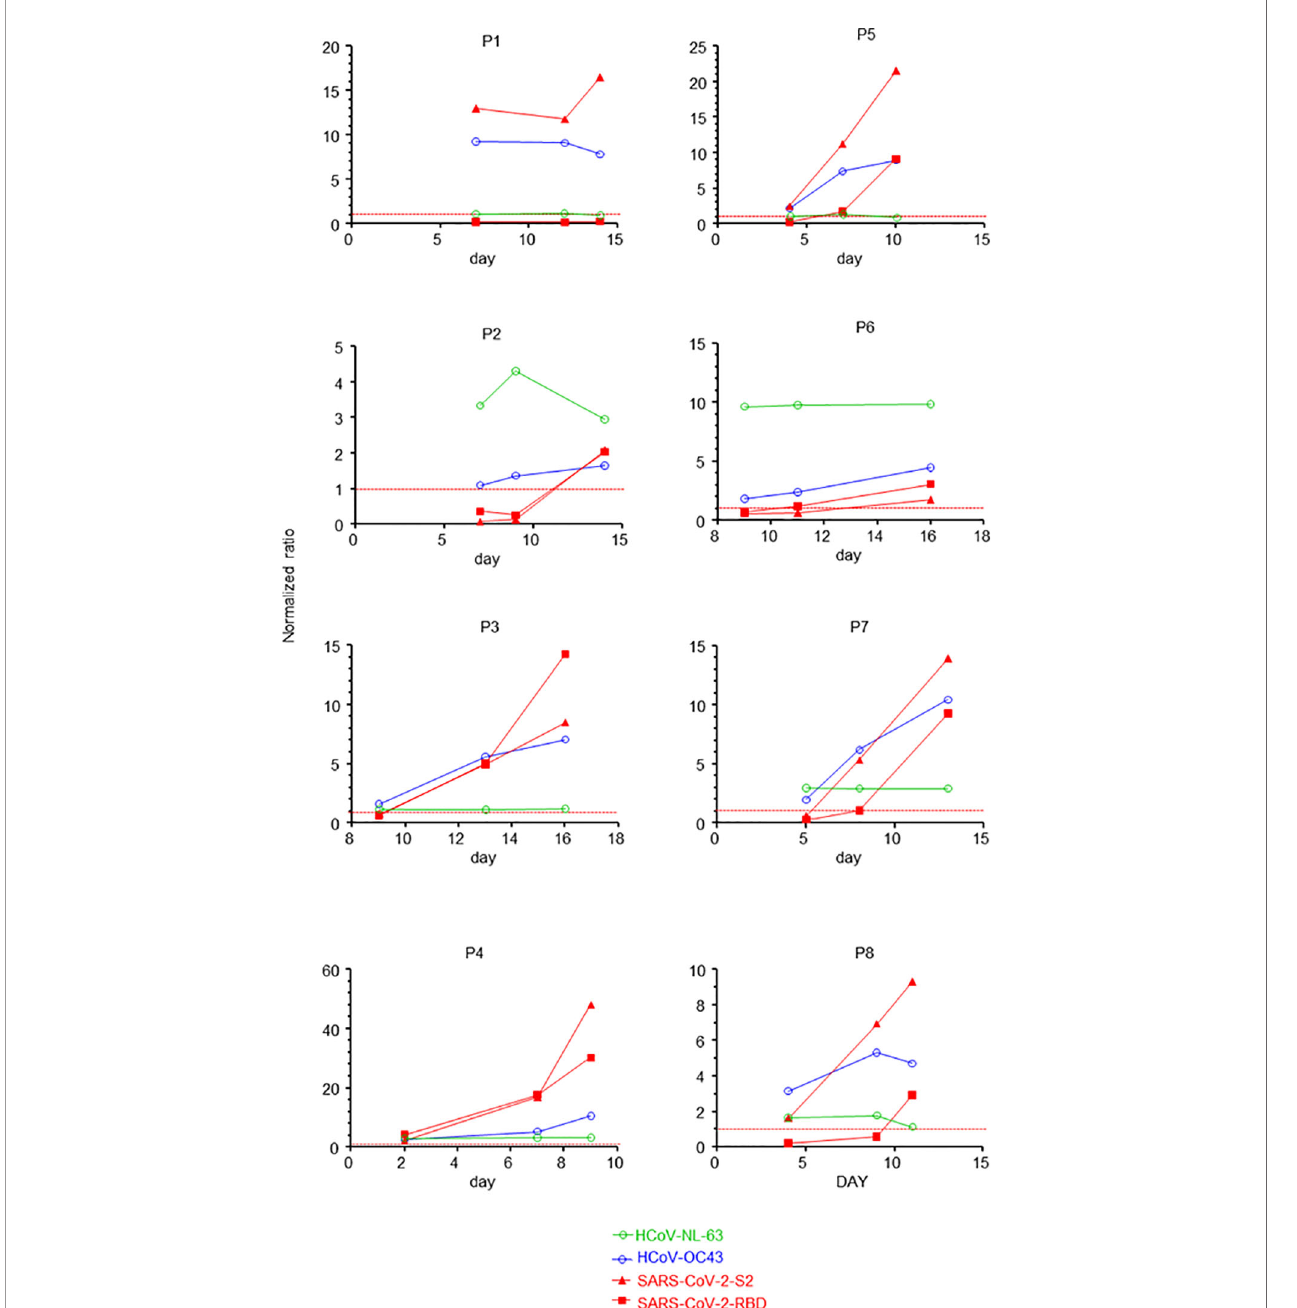
FIGURE 1 | SARS-CoV-2 infection induces HCoV-speci fi c recall responses. Time course of normalised IgG reactivity against SARS-CoV-2 RBD and the S2 domain of the spike protein, alpha-HCoV-NL-63 and beta-HCoV-OC-43 of the sera of eight patients (P1 to P8) with con fi rmed severe COVID-19. Dotted red lines indicate threshold values for positivity (normalised to